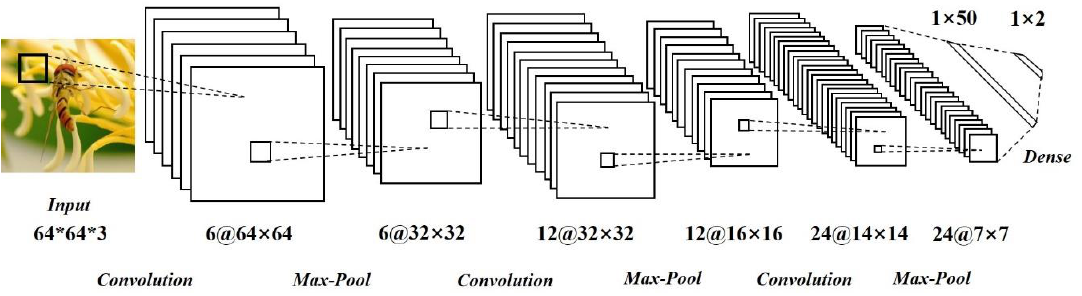
Figure 4. The topology of used convolutional neural network (CNN).